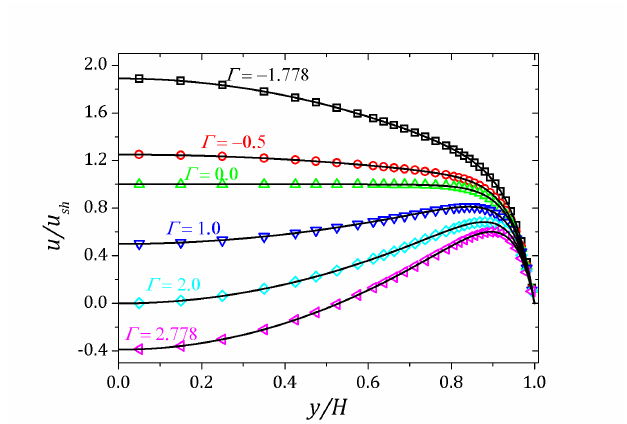
Figure 11. Velocity profiles for a Newtonian flow subject to an external pressure gradient. Results for κ = 20.